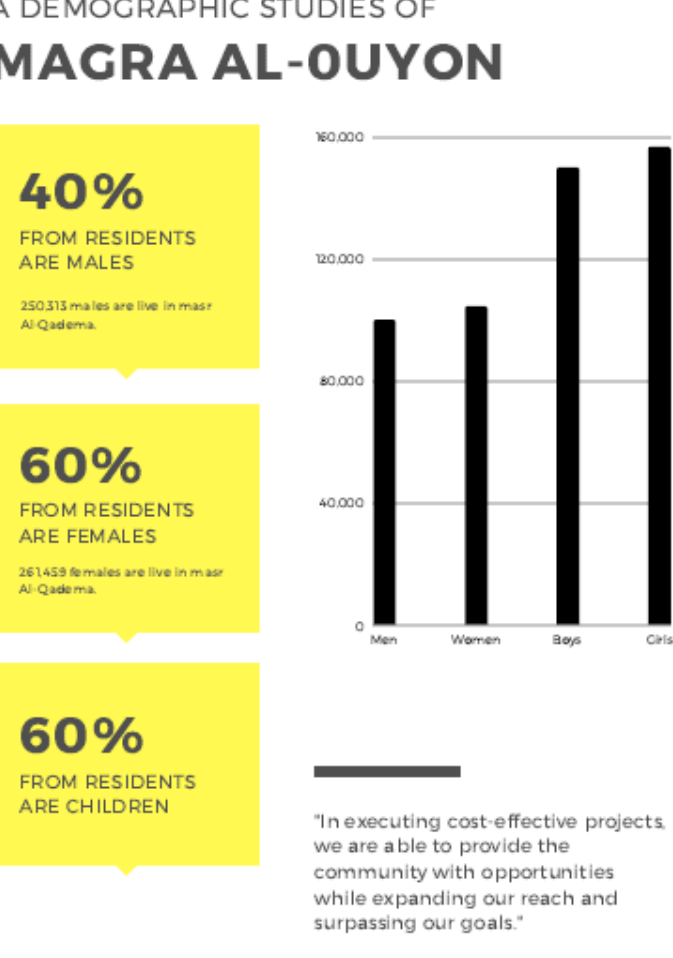
Figure 7. Demographic studies (Students